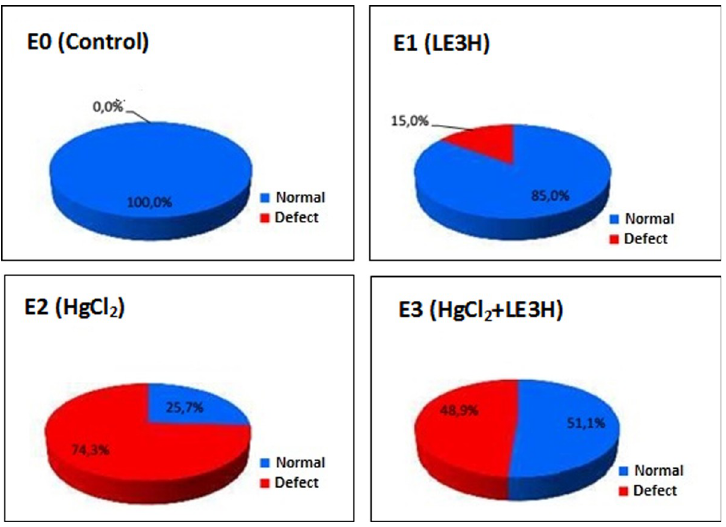
Fig 4. Percentage normal and defective anatomy in Morphologically Normal Living Fetuses (MNLF) of M . musculus on Gestation Day (GD)18 which previously were given 0.39 mg/kg bw LE3H through gavage on GD10 (E1), injected with 5 mg/kg bw HgCl 2 on GD9(E2), and administered 5 mg/kg bw HgCl 2 on GD9 and then 0.39 mg/g bw LE3H on GD10(E3). Meanwhile the controls (E0) were administered double-distilled water only.